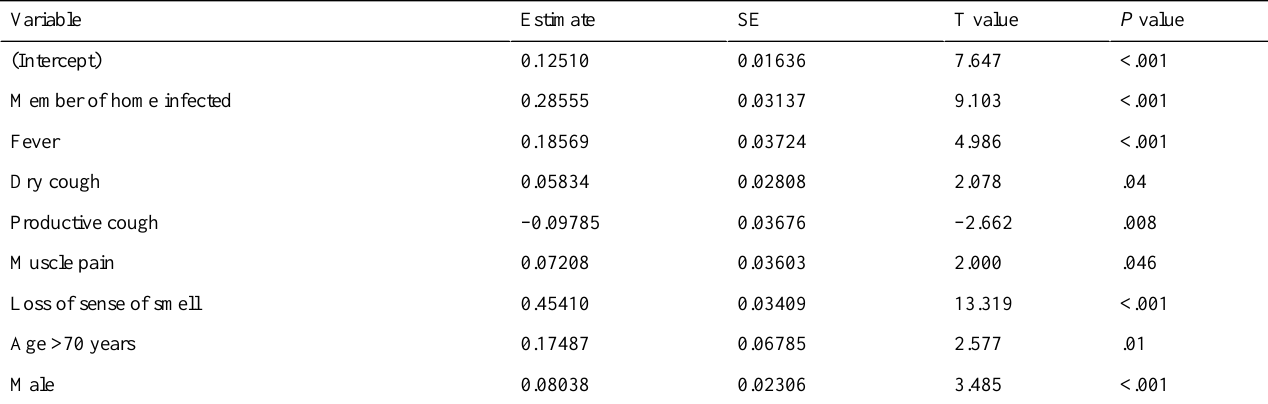
Table 4. Selected variables and coefficients of the generalized linear model.